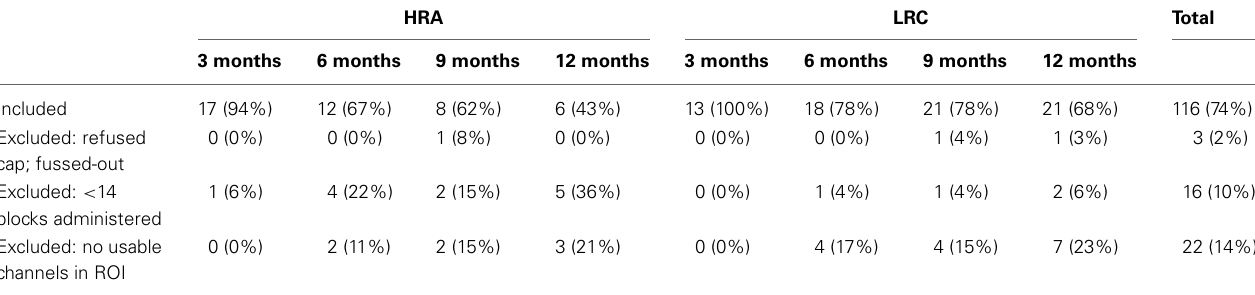
Table 2 | Attrition rates for entire sample of